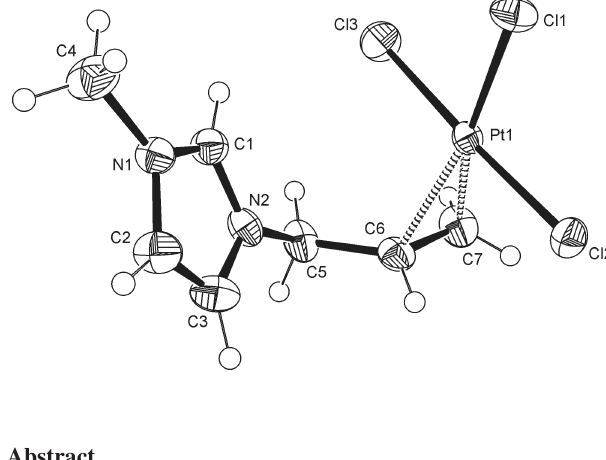
Table 1. Data collection and handling.